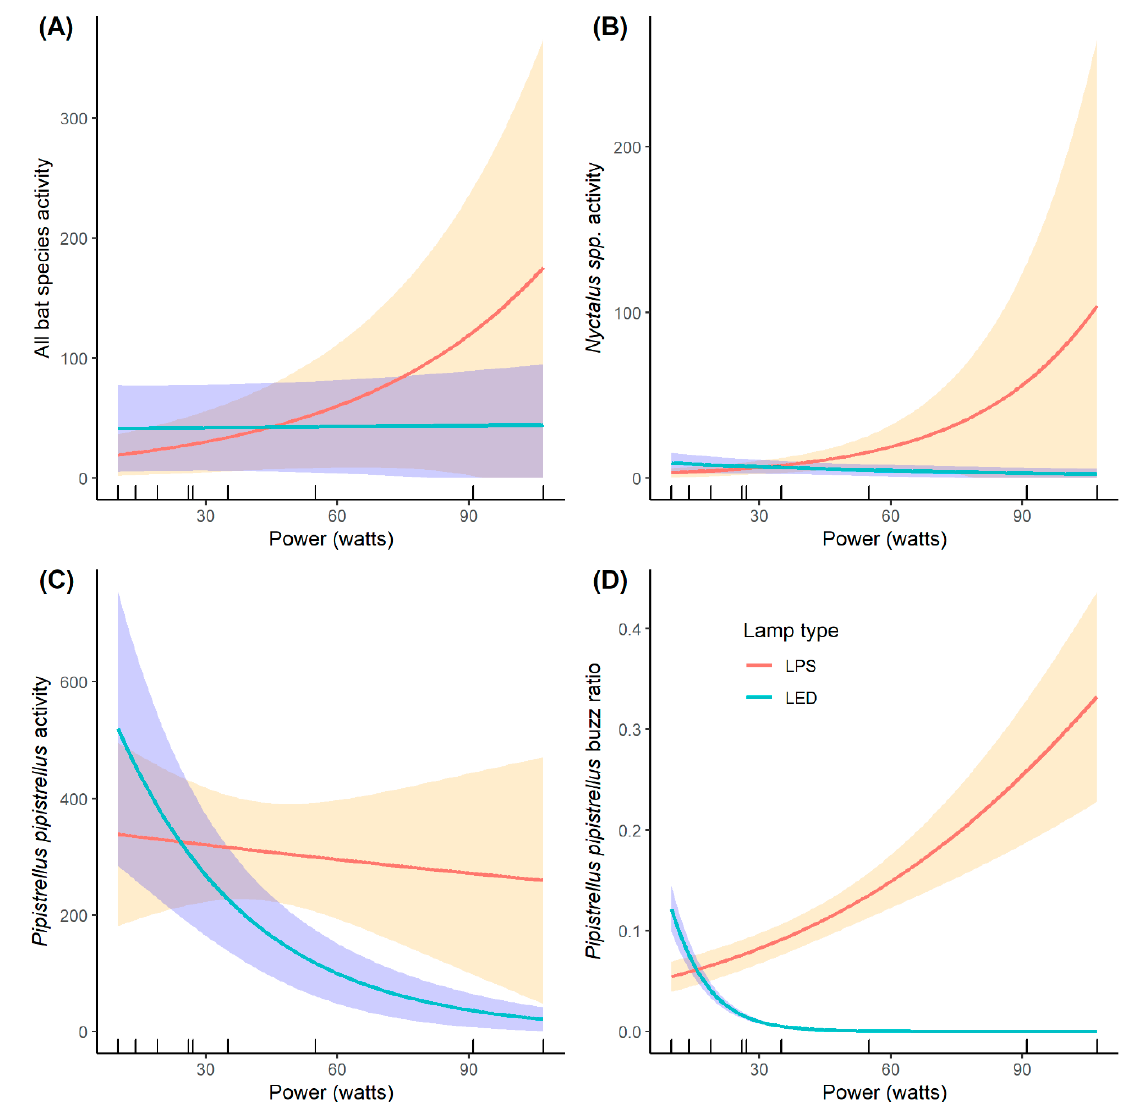
Figure 2. Predicted bat activity (total bat activity could ( A ), Nyctalus spp . Activity ( B ), Pipistrellus pipistrellus activity ( C ) and P. pistrellus buzz ratio ( D )) as a function of the light power according to the lamp type (light emitting diodes (LED) and low pressure sodium (LPS)). Results come from interactions presented in the light power modeling (right side of Table 2).